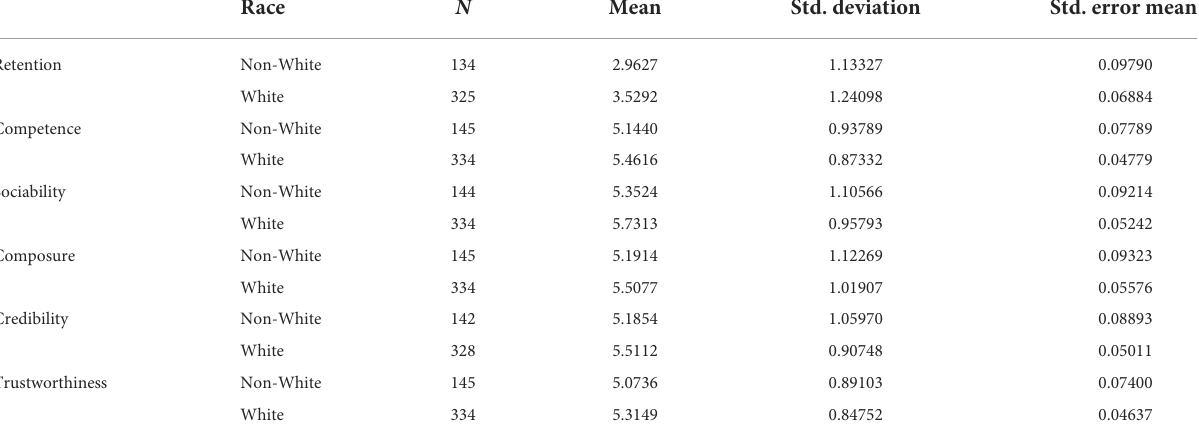
TABLE 2 Experiment 1 – group